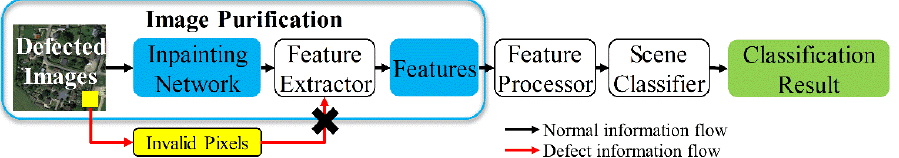
Figure 2. New RSISC task procedure to solve the dilemma. The defect information flow introduced by invalid pixels is cut off by the inpainting network as the black X- shape shown, and the feature extractor can extract more purified features.